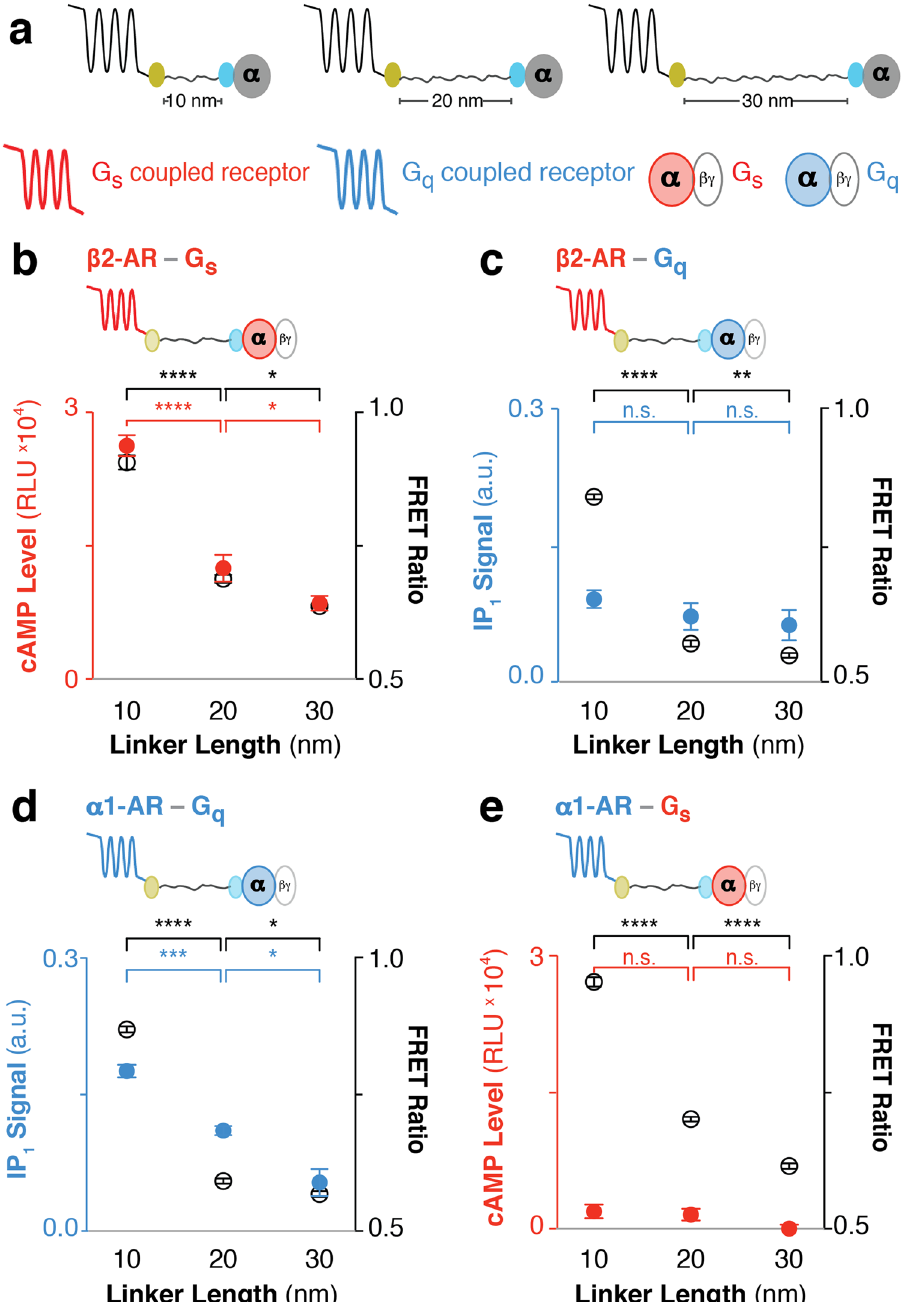
Figure 5. ER/K linker length specifically modulates basal β 2-AR-Gs and α 1-AR-Gq downstream response in live cells. ( a ) Schematic of the GPCR-G protein fusions. Color represents cognate GPCR-G protein pair and corresponding downstream response (red: β 2-AR, Gs, and cAMP levels; blue: α 1-AR, Gq, and IP 1 signal). (b – e ) Fusion type is indicated on the top left. FRET Ratios (525 nm/475 nm; open black circles, right y-axis) and basal (ligand-free) downstream response (filled colored circles, left y-axis) are compared to ER/K linker length (nm). ( b ) cAMP levels or ( c ) IP 1 signal for β 2-AR tethered to cognate Gs or non-cognate Gq respectively. ( d ) IP 1 signal for cognate α 1-AR-Gq fusions. ( e ) cAMP levels for α 1-AR tethered to non-cognate Gs. ( b – e ) One-way ANOVA with a Tukey’s post-test was performed for FRET measurements (black) and downstream response (colored). Data are derived from at least three independent experiments, with at least three replicates per condition (mean ± S.E.M. * p ≤ 0 . 05 ; ** p ≤ 0 . 01 ; *** p ≤ 0 . 001 ; **** p ≤ 0 . 0001 ). For additional statistical analysis see Supplementary Table